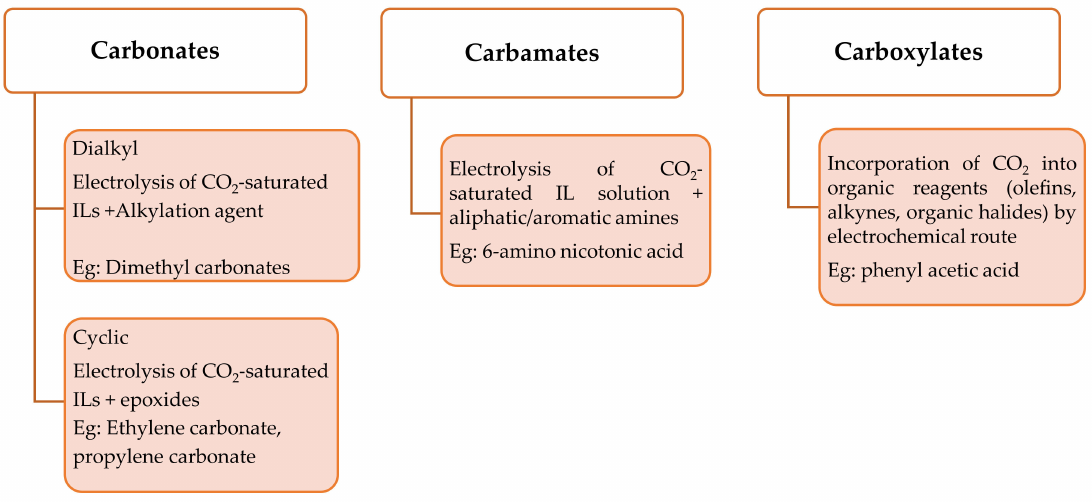
Figure 4. Summary of the organic products that were obtained from electrosynthesis via the CO 2 transformation route